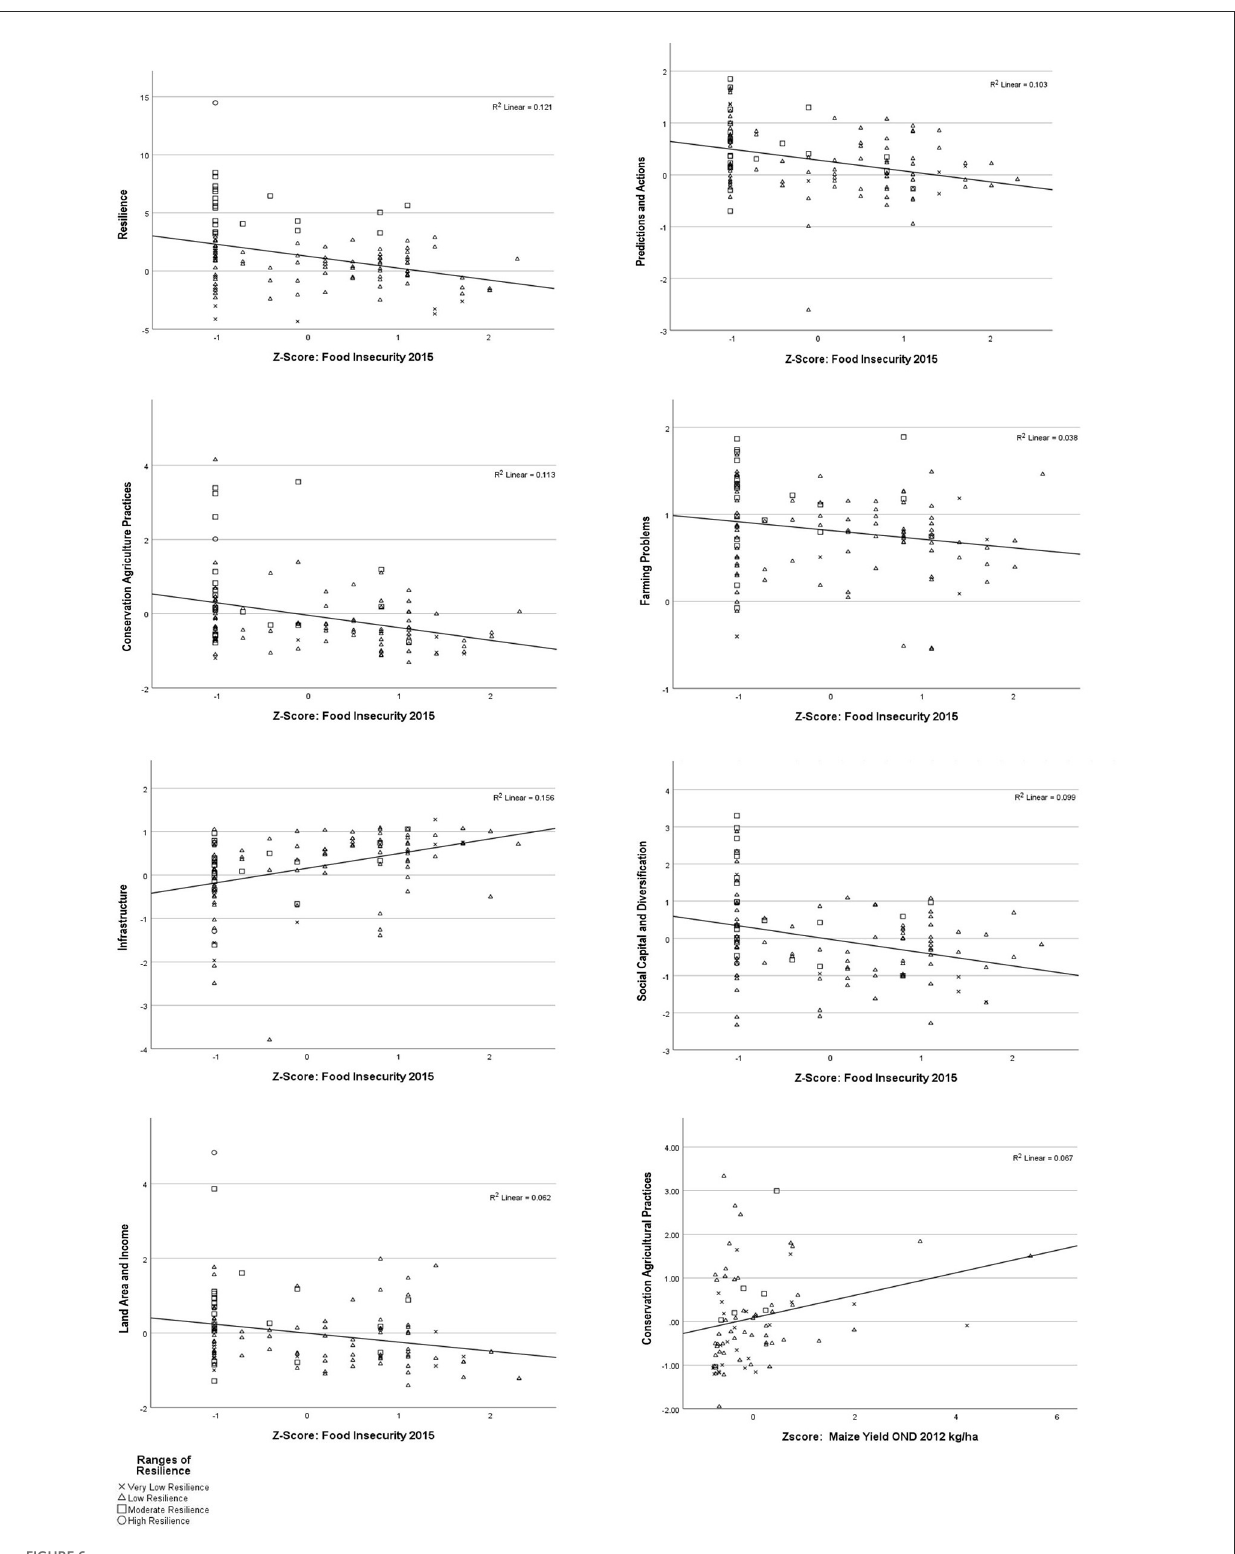
FIGURE6 Scatterplots resilience components and food insecurity/maize yields.